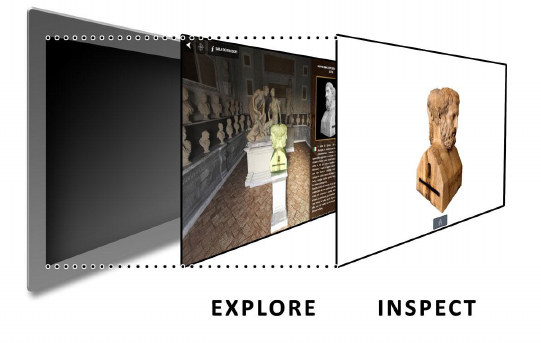
Figure 10. Exploration and Inspection interactive layers.